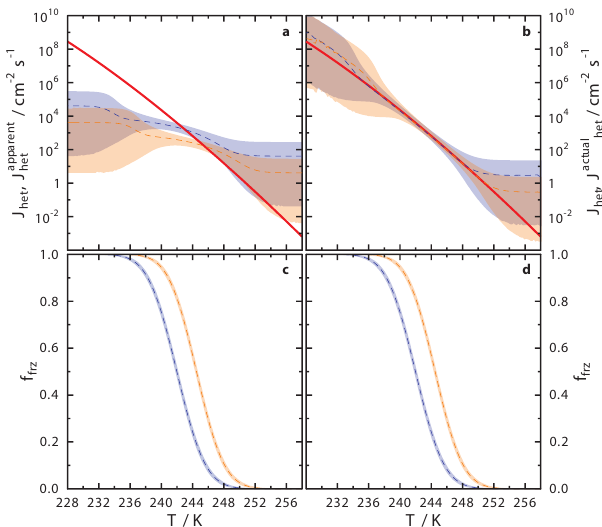
Figure 4. Sensitivity calculations of heterogeneous ice nucleation rate coefficients, J het , and frozen droplet fractions, f frz , on cooling rate, r , derived from model simulations Cr1 (orange) and Cr2 (blue) where r = 0 . 5 and 5 . 0Kmin − 1 , respectively. J het as a function of temperature, T , are shown in (a) assuming uniform ice nuclei sur- face area (ISA) per droplet yielding J apparent , and (b) accounting het for different ISA yielding J actual . The dashed lines in (a) and (b) are het actual J apparent and J het , respectively. Shadings in (a) and (b) corre- het spond to upper and lower fiducial limits with x = 0 . 999 confidence and the solid red line is calculated from Eq. (6) for illite (Knopf and Alpert, 2013). Frozen droplet fractions, f frz , are shown in (c) and (d) where dashed lines and shadings represent f frz and 5 and 95% bounds, respectively. Parameter values for Cr1 and Cr2 are given in Table 2.